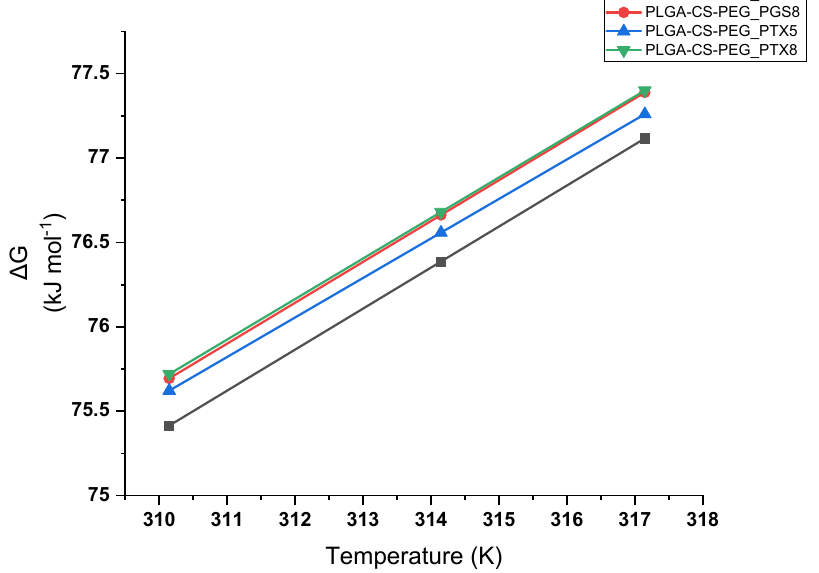
Figure 5. A graph of Gibbs free energy vs. temperature for PLGA-CS-PEG microspheres at different temperatures.